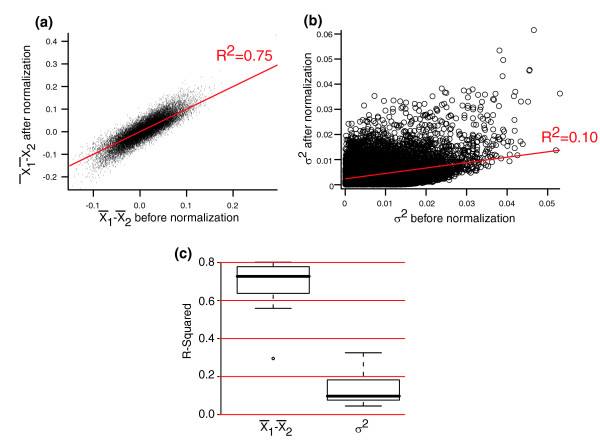
Estimates of standard error do not survive quantile-quantile normalization. (a,b) x¯1−x¯2
 MathType@MTEF@5@5@+=feaafiart1ev1aaatCvAUfeBSjuyZL2yd9gzLbvyNv2Caerbhv2BYDwAHbqedmvETj2BSbqee0evGueE0jxyaibaiKI8=vI8tuQ8FMI8Gi=hEeeu0xXdbba9frFj0=OqFfea0dXdd9vqai=hGuQ8kuc9pgc9s8qqaq=dirpe0xb9q8qiLsFr0=vr0=vr0dc8meaabaqaciGacaGaaeqabaqadeqadaaakeaaieaaceWF4bGbaebadaWgaaWcbaGaaGymaaqabaGccqGHsislceWF4bGbaebadaWgaaWcbaGaaGOmaaqabaaaaa@381E@ (panel a) and σ2 (panel b) before and after background correction and quantile-quantile normalization for the comparison of the Latin Square experiments 1 and 2. Fits shown are to a linear regression. (c) Box plot showing the R2 values from a linear fit for all 14 2× Latin Square comparisons.